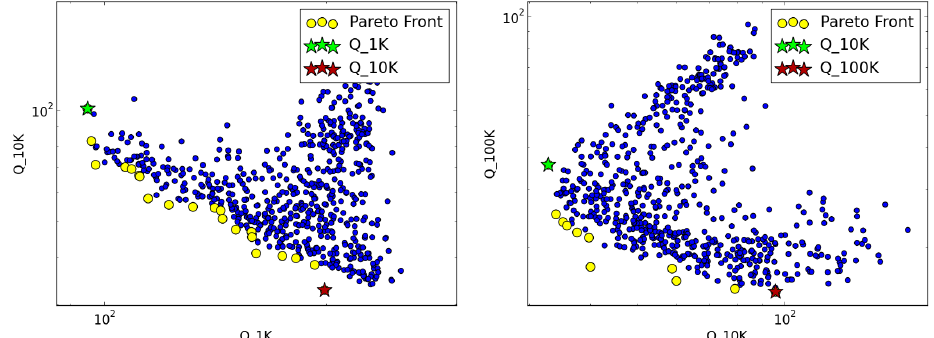
Figure 6. Fitness values of all the solutions found in ten independent runs of EMOPaT for the three criteria, plotted pairwise for adjacent values of the budget. The green and red stars represent the Top Solutions for each objective, yellow circles are candidate solutions for intermediate evaluation